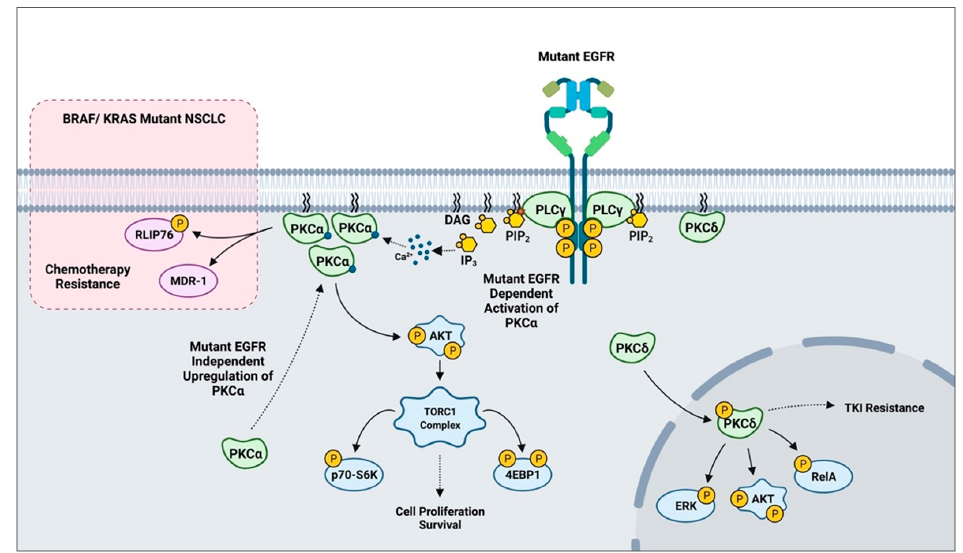
Figure 4. A scheme outlining PKC-mediated drug resistance in EGFR and KRAS mutant